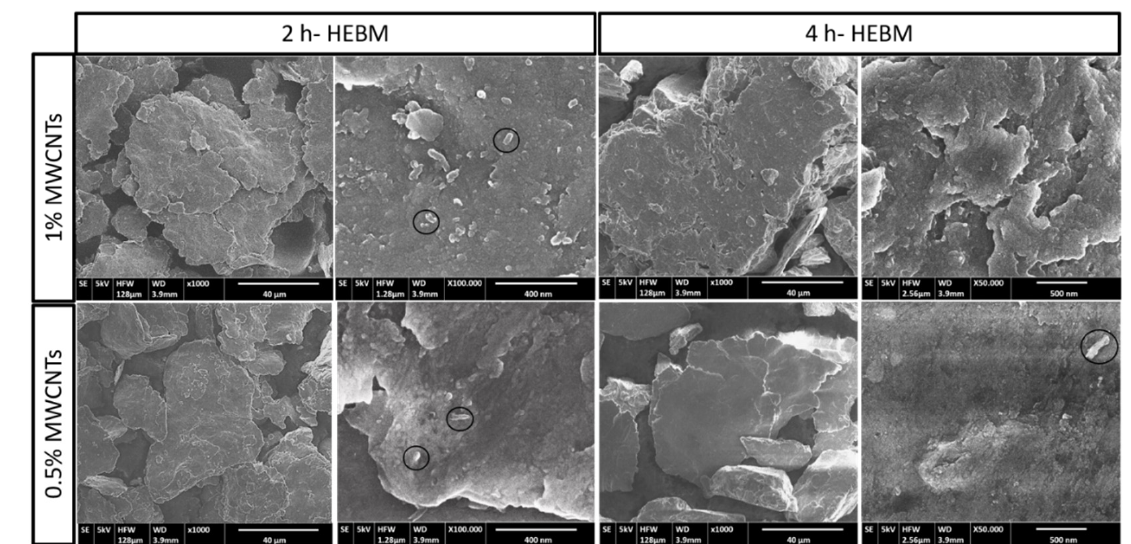
Figure 8. SEM micrographs of 7075-1 wt.% MWCNT and 7075-0.5 wt.% MWCNT powders after 2 h and 4 h of high energy milling time.